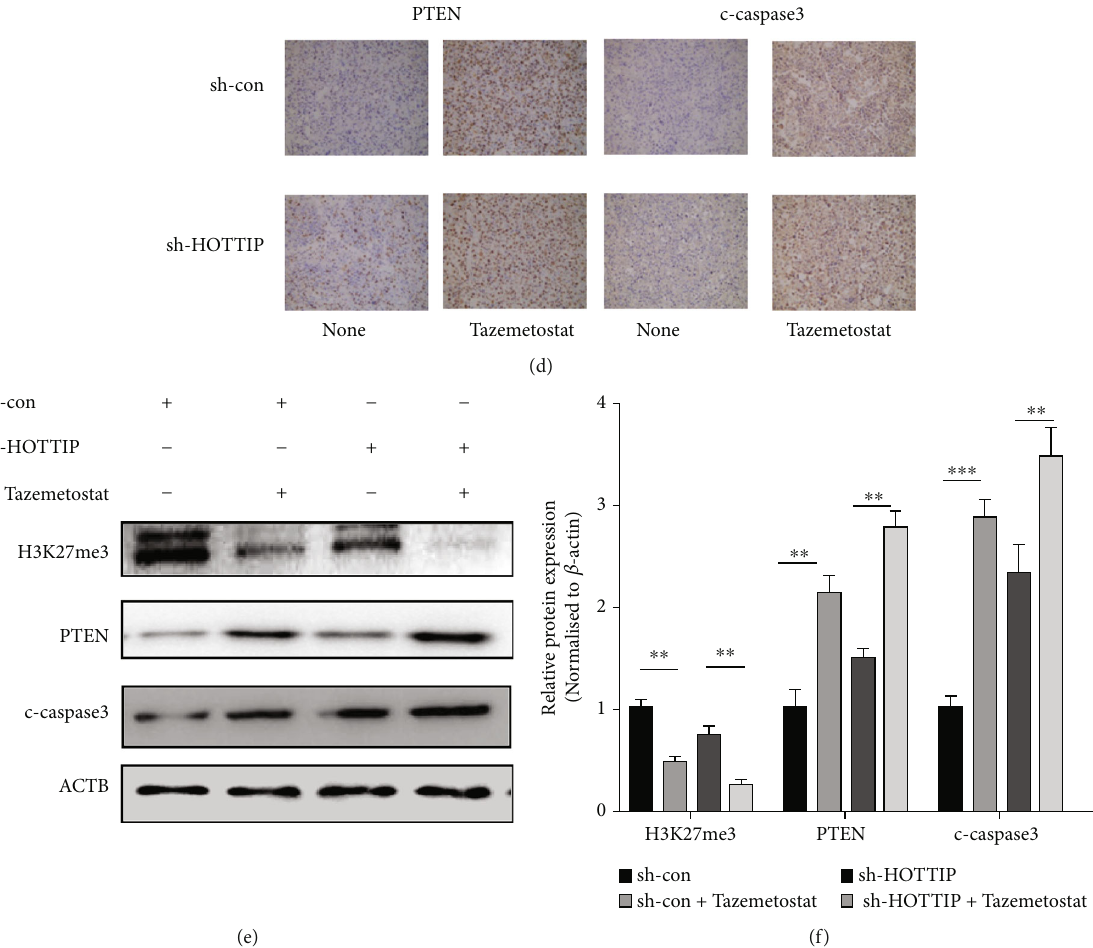
Figure 7: The e ff ect of HOTTIP on CML cell in vivo. Note: (a) Tazemetostat drug structure. (b) Analysis of H3K27me3. PTEN expression in IR-K562 cells treated by Tazemetostat with di ff erent concentrations for 48h. ∗∗∗ p < 0 : 001 vs. DMSO. (c) IR-K562 cells were engineered to stably knock down HOTTIP, and the cells were then subcutaneously injected into the nude mice to establish CML xenograft tumors. Tumor volumes were monitored by direct measurement. ∗ p < 0 : 05 , ∗∗ p < 0 : 01 , and ∗∗∗ P < 0 : 001 vs.sh-con. Representative tumor sizes of xenograft mice in each group. The xenograft tumor wet weight in each group of mice. ∗ p < 0 : 05 , ∗∗ P < 0 : 01 vs. sh-con. (d) Immunohistochemistry stain was used to measure the PTEN, c-caspase3 protein levels in xenograft tumors. (e) Western blot was used to detect the H3K27me3, PTEN, and c-caspase3 protein levels in xenograft